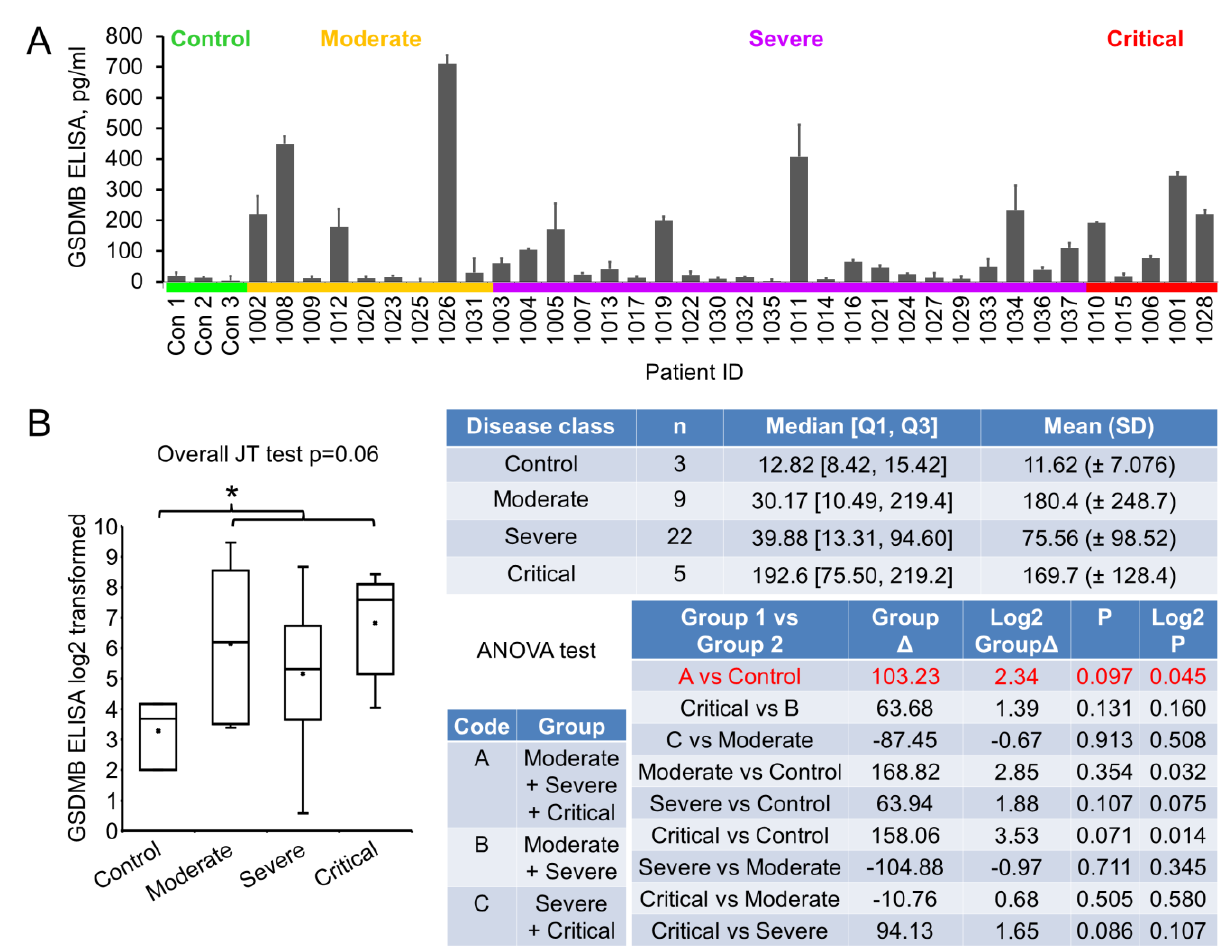
FIGURE 4: Gesdermin B expression in early plasma. (A) Plasma GSDMB levels were determined with ELISA. Plasma (50 µl) were diluted to 100 µl and added to anti- GSDMB coated wells in duplicate. Data were groups by disease stage and expressed as mean ± SD. (B) Statistical analysis of GSDMB levels with disease stages. Graph shows log2 transformation of the original values. Note that one original value in moder- ate group was 0, so the transformed meaningless value was removed, resulting in the decreased average compared to that in critical group. *, p<0.05 with ANOVA test. ∆,